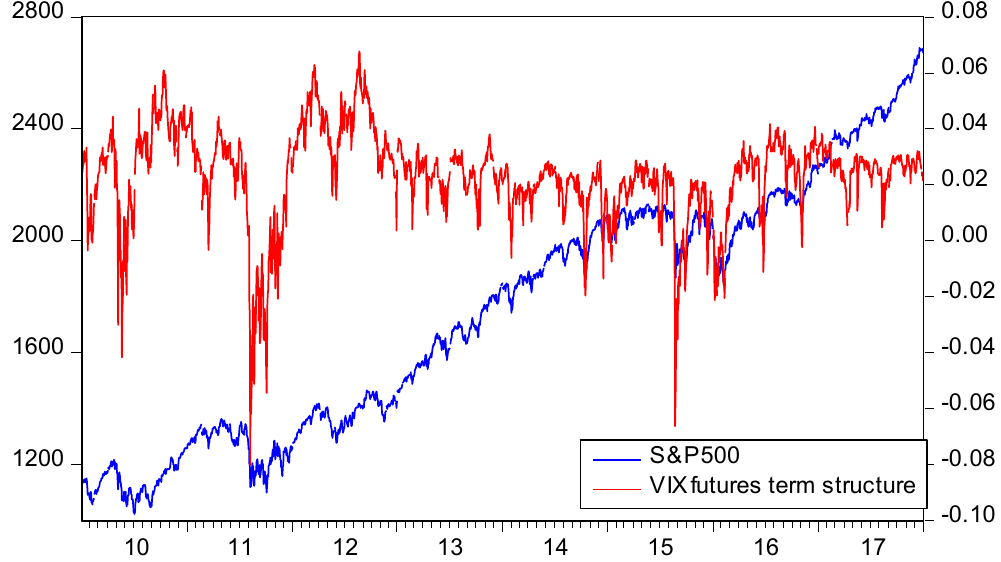
Figure 1. VIX futures term structure and S&P500 (January 2010–December 2017). The estimation of the VIX futures term structure was conducted on each trading day by fitting a linear model of the available contracts and cash VIX as a function of time to maturity based on the least squares criterion (the spot VIX index is considered as the price for VIX futures with zero maturity). The estimated term structure is in units of volatility percentage points per year.